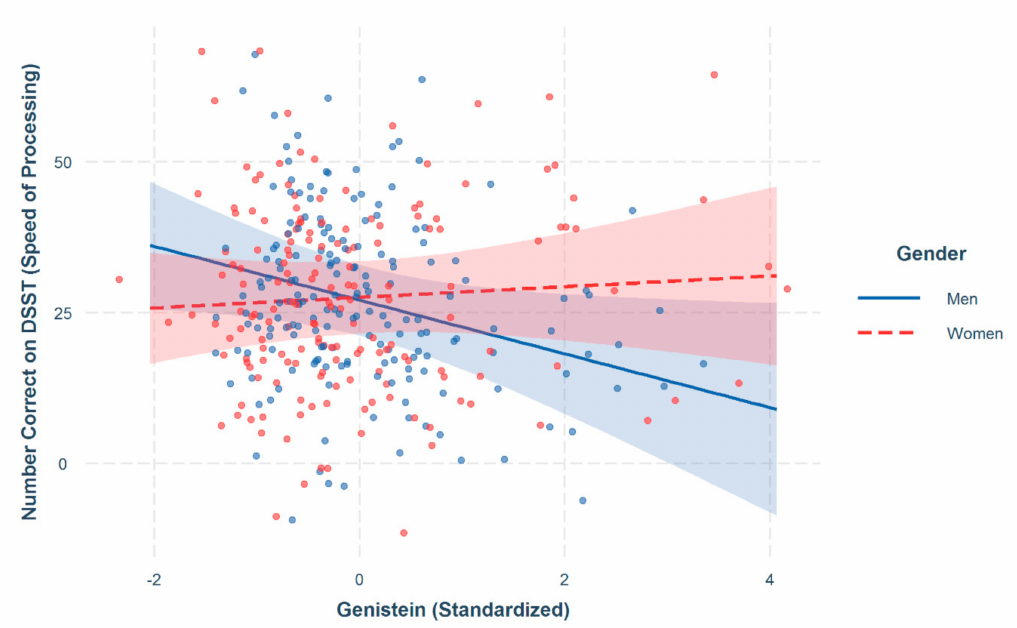
Figure 2. Significant interaction between genistein intake and Digit Symbol Substitution Test Performance(SpeedofProcessing)forbothmenandwomen; 95%confidenceintervals. Note: Covariates controlled for included age, BMI, ethnicity, education, smoking, fasting status, poverty-income-ratio (PIR), and creatinine. The scatterplot refers to the actual observed values with each color corresponding to gender. Red dots refer to women and blue dots refer to men. Table 2. Gender Di ff erences in Phytoestrogen Intake and Speed of Processing Performance in Older